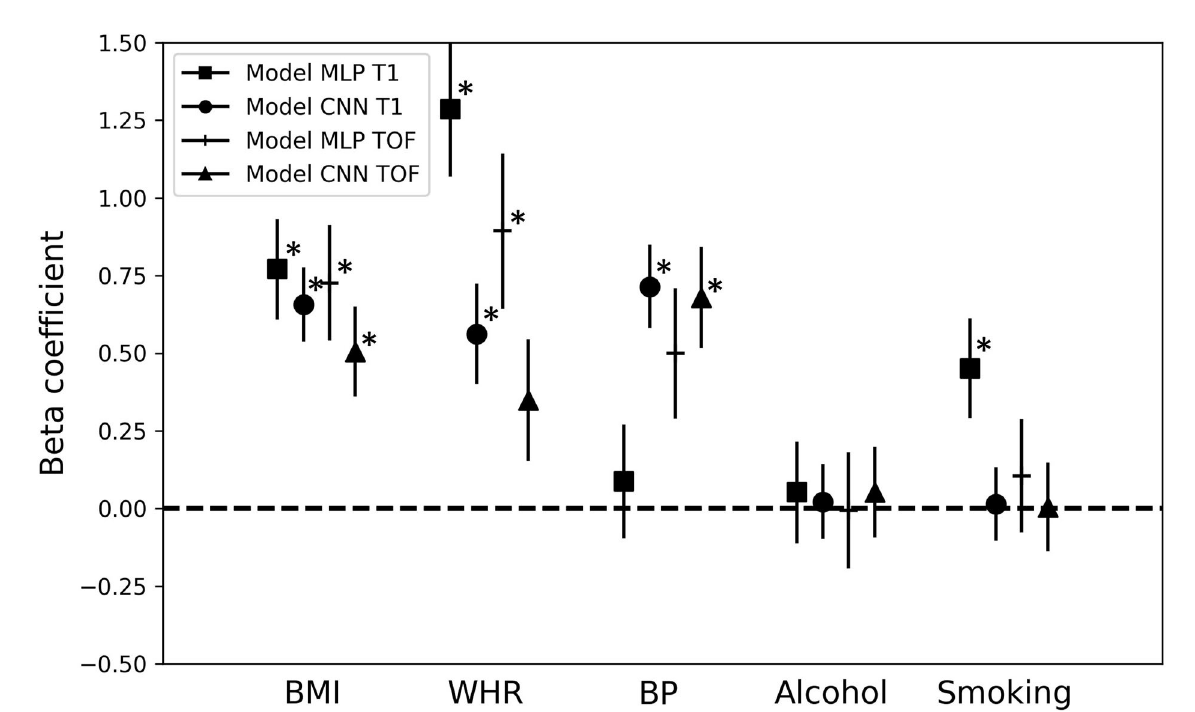
FIGURE5 Association of the brain age gap with cardiovascular risk factors. Beta coefficients and their error bars for the different cardiovascular risk factors for each multiple regression model predicting the brain age gap for the different brain age prediction models. * p < 0.05; MLP, Multilayer perceptron; CNN, Convolutional neural network; T1, T1-weighted MRI; TOF, Time-of-flight MRA; BMI, Body-mass-index; WHR, Waist-to-hip ratio; BP, Blood